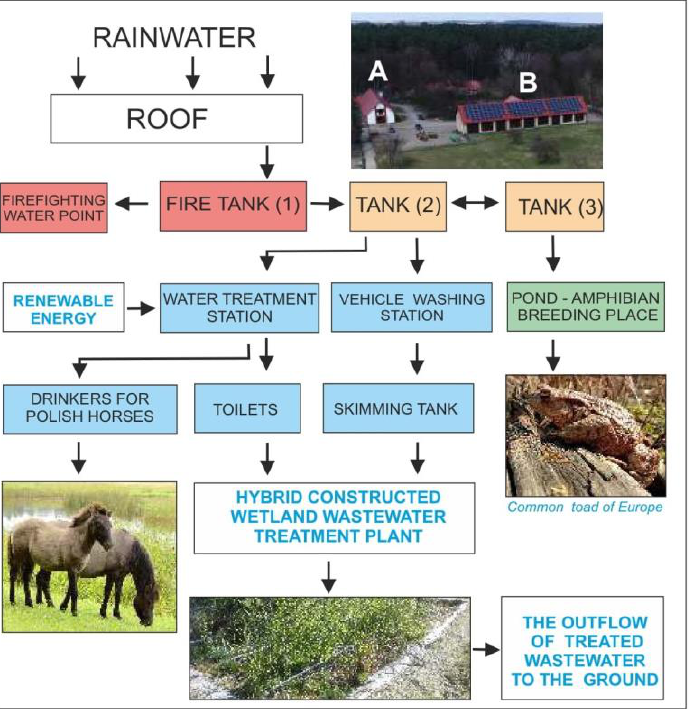
Figure 7. Diagram of a sustainable rainwater management system in the Animal Breeding Centre in Florianka in the Roztocze National Park. A—stable and B—barn.